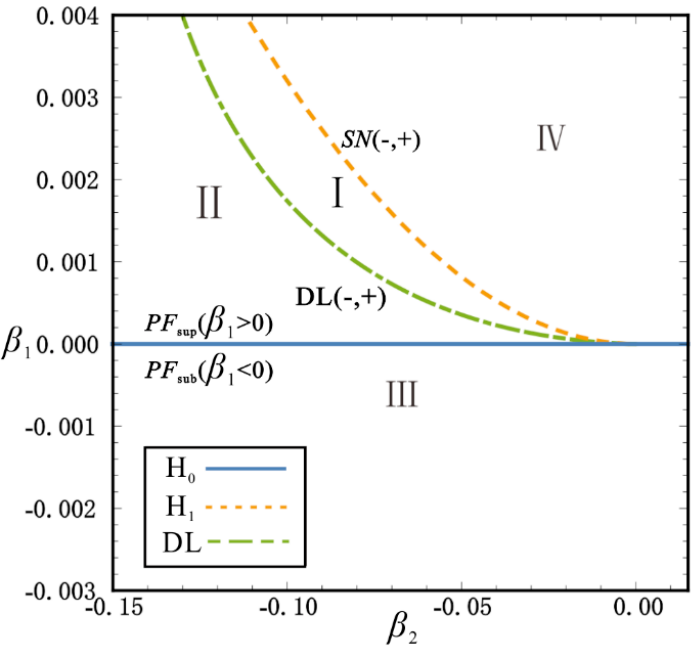
− β Figure 2. Transition set on the β 1 − β 2 plane. Figure 2. Transition set on the β 1 2 plane. The focus is now on the parameter spaces where the quad-stable and tri-stable states occur. By referring to the bifurcation theory to select reasonable structural parameters, the dynamical behaviors of the system with tri-stability and quad-stability are investigated. Figure 4 shows the time history diagrams and phase diagrams solved by the fourth-order Runge-Kutta method. The quad-stable behavior is evident in Figure 4a,b, so as the tri-stable behavior in Figure 4c,d. It should be noted that harmonics and chaos in the response are ignored, and different intra- or inter-well motions can be derived from different initial conditions. Through increasing the external input energy, the oscillator can escape the single-well and achieve global inter-well vibrations, which can generate higher output power. Therefore, it is an important goal in the design of energy harvesters to keep the potential energy barriers as weak as possible in order to enable the harvester to rapidly reach the energy threshold required for the inter-well